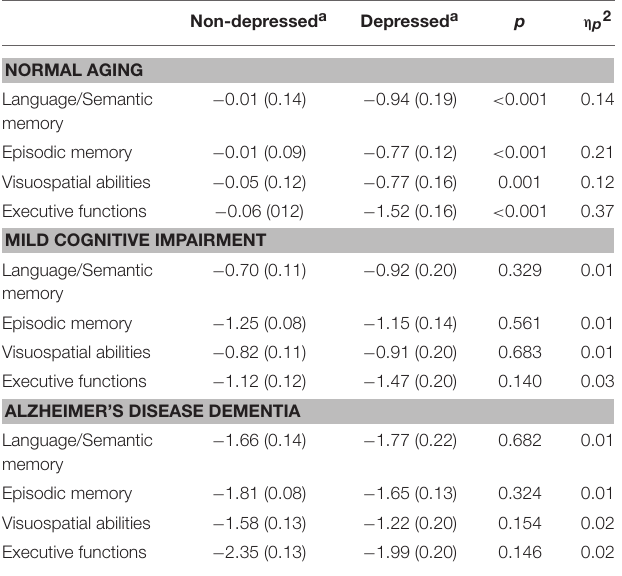
TABLE 4 | Main effect of depression in cognitive functions and group comparison’s after covariating age and education. Non-depressed a Depressed a p η p 2